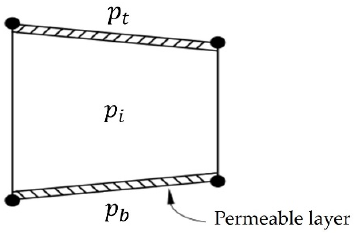
Figure 2. Flow pattern of fluid in fracture.